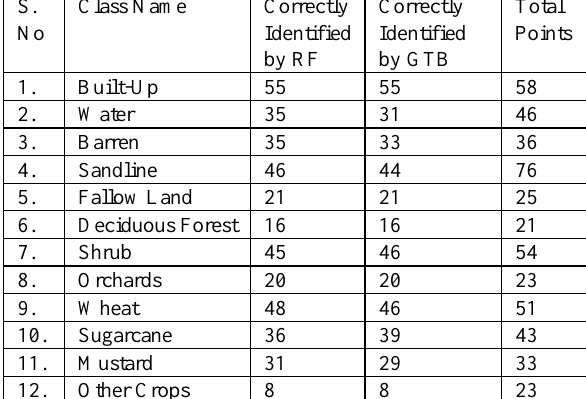
Table 6: Total No of Points Correctly Classified by RF